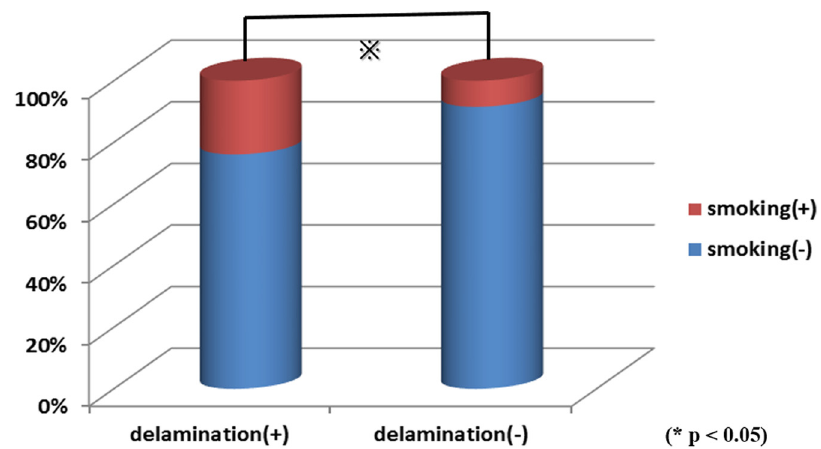
Figure 5. Relation of delamination and